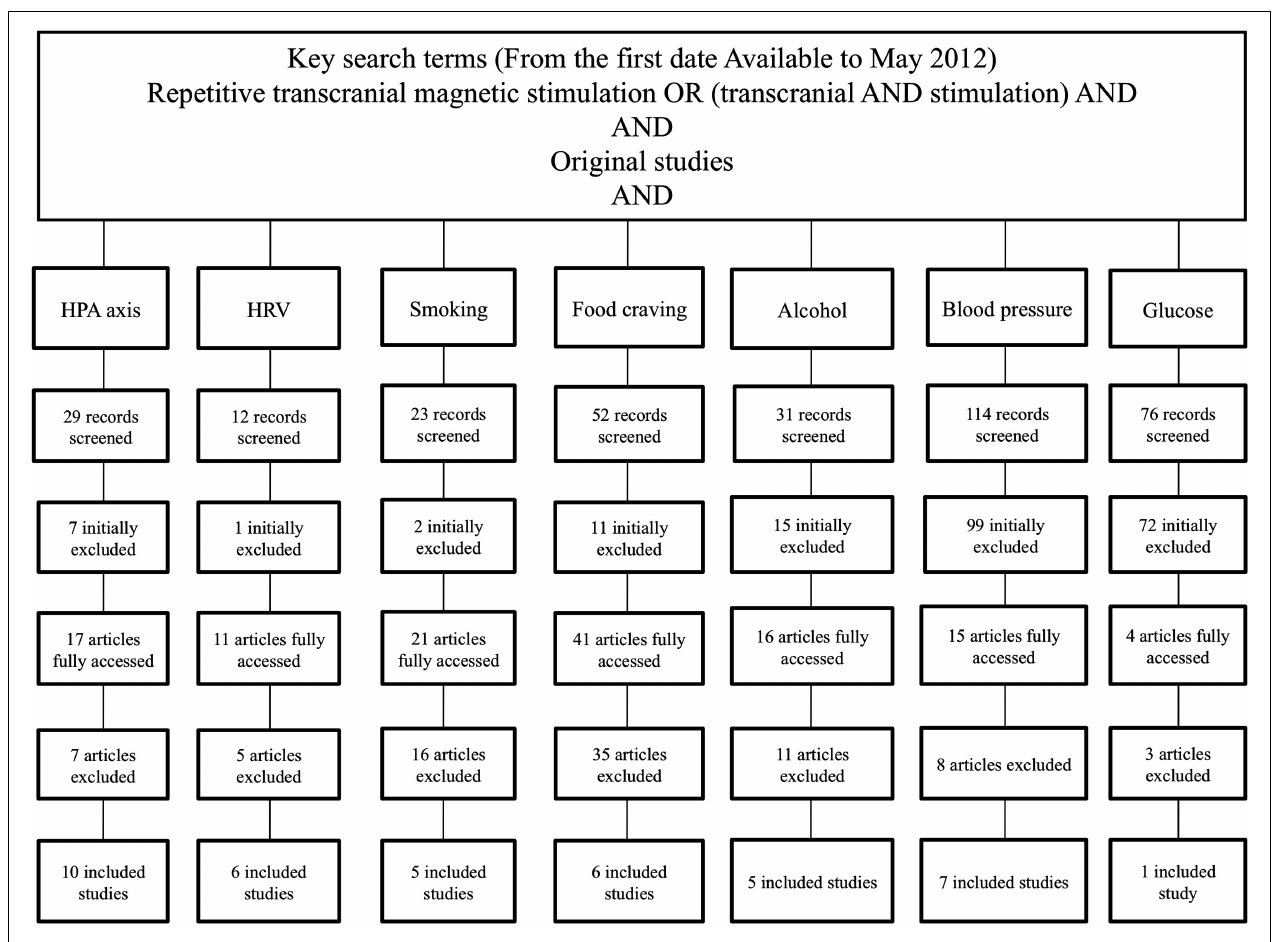
FIGURE 1 | Flow chart of reviewed studies, according to PRISMA guidelines. The complete key search terms are described in the main